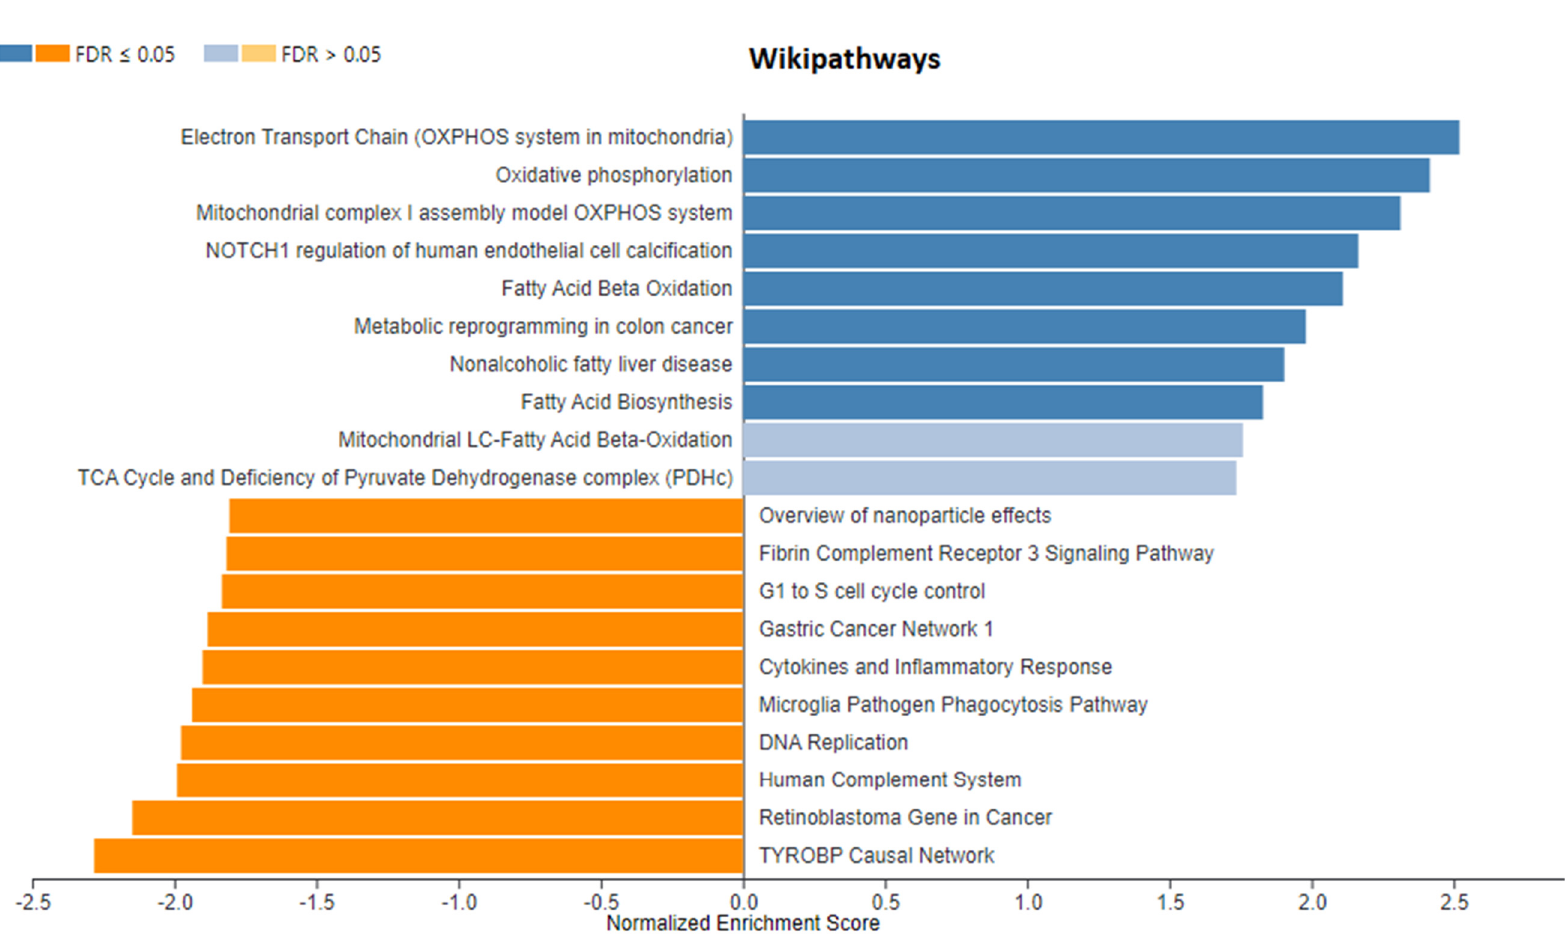
Figure 6. Enriched Wikipathways (Homo sapiens) identified in rapeseed oil vs. beef tallow dataset by WebGestalt software. Positive normalized enrichment score indicates that genes from the pathway are at the top of the ranked list (mostly upregulated). Negative normalized enrichment score indicates that genes from the pathway are at the bottom of the ranked list (mostly downregulated) (the first group in the comparison is the reference group).